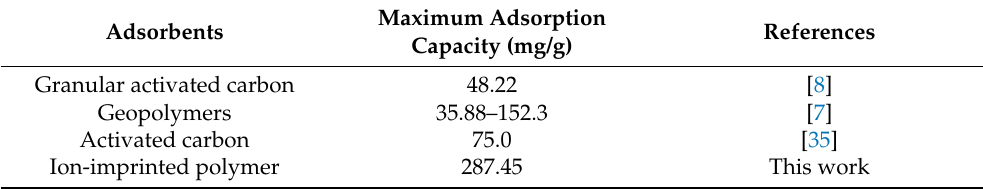
Table 3. Comparison of maximum adsorption capacity of copper(II) ions using different